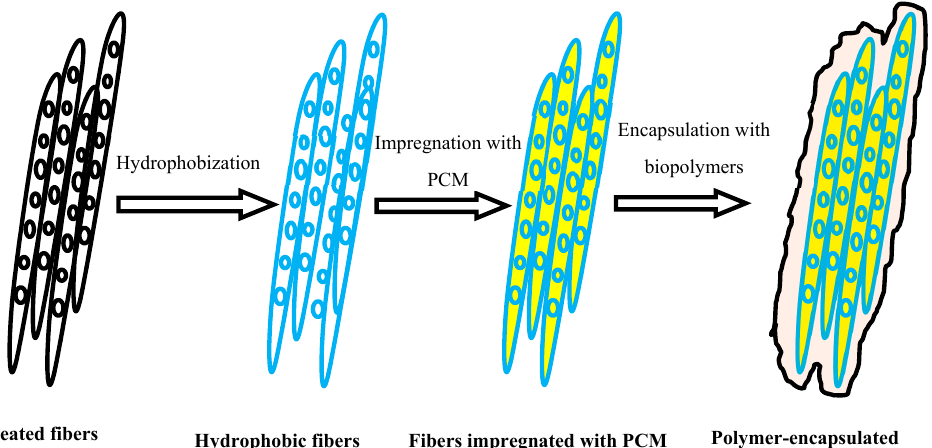
Figure 4. Schematic representation of incorporating PCMs into bio-fibers.